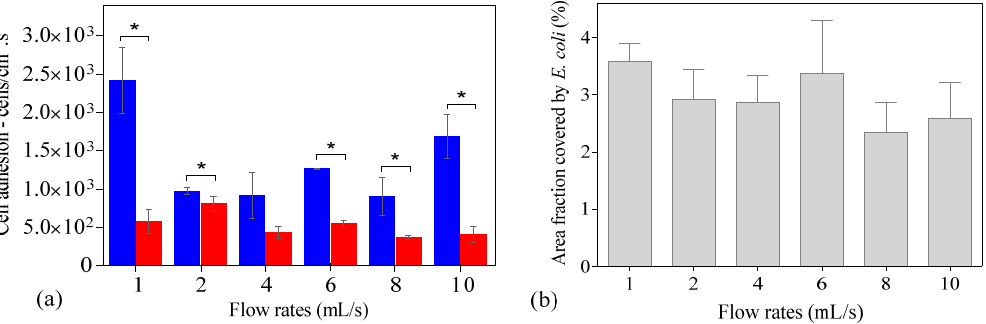
Figure 3. ( a ) Initial adhesion rates determined by linear regression of the first experimental points (blue bar) and for the remaining points (red bar) at different flow rates (1 to 10 mL/s). Statistical significance between the adhesion rates and the different flow rates was evaluated by one-way analysis of variance (one-way ANOVA, Tukey’s post-hoc test) ( p < 0.05); ( b ) Area fraction covered by Escherichia coli cells at the end of adhesion assay (30 min) on polydimethylsiloxane (PDMS) at different flow rates (1 to 10 mL/s).